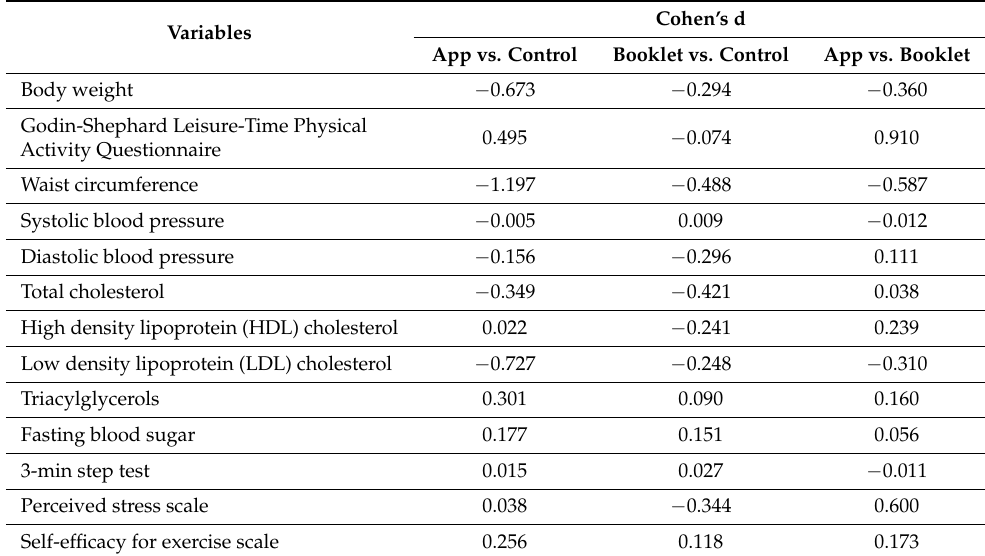
Table 2. Comparing the effects of the app and booklet group at week 24.